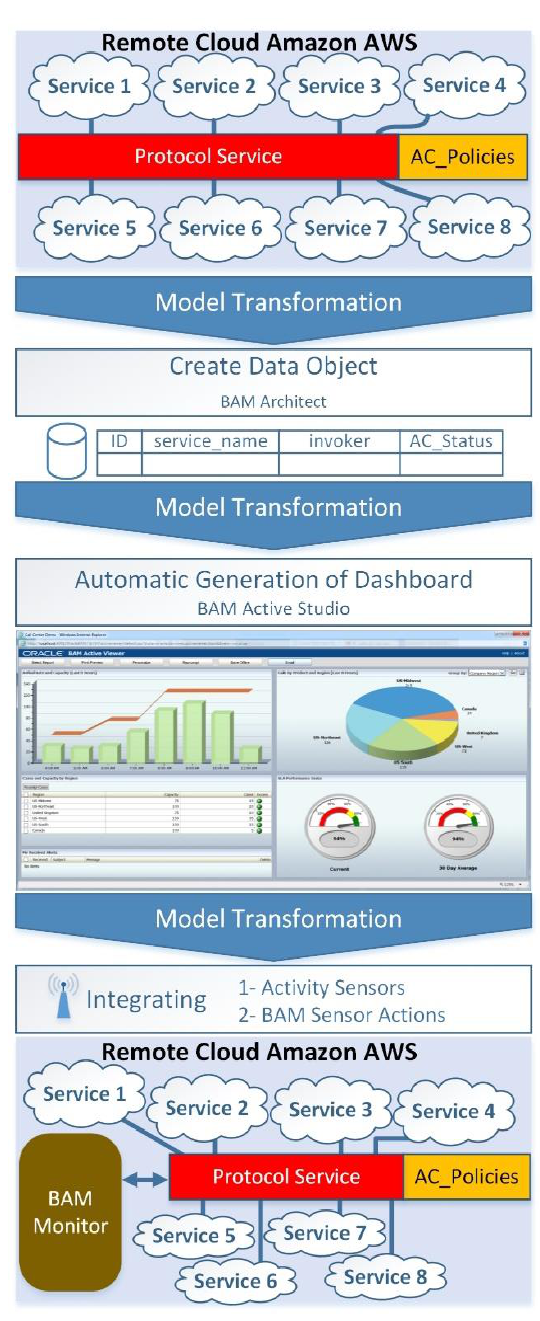
Fig. 14. Outline of the automatic generation of the monitoring